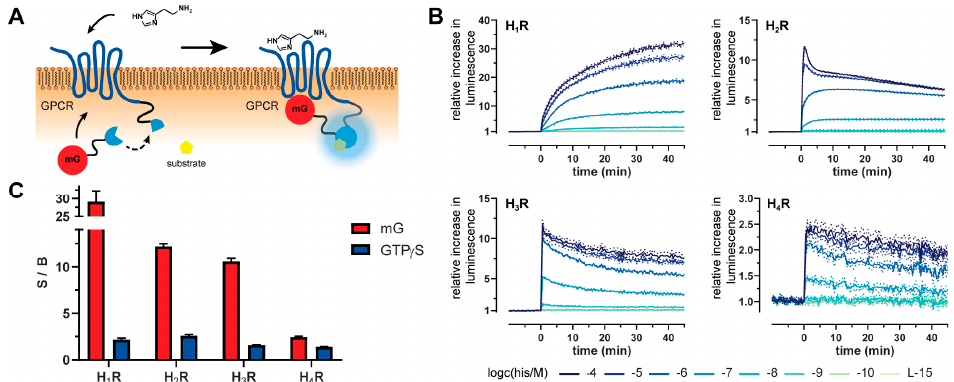
Figure 1. Principle of the mini-G protein recruitment assay and obtained signals at the H 1–4 R. ( A ) Scheme of the mini-G protein recruitment assay. The split-NanoLuc technology was applied to the H 1–4 R (C-terminus) and the mini-G proteins (mG; N-terminus). Upon receptor activation, the mini-G protein is recruited to the GPCR and the split-NanoLuc fragments form a functional enzyme leading to the oxidation of the substrate and thus luminescence signals in an agonist concentration-dependent manner. ( B ) Representative luminescence traces of the mini-G protein recruitment of mGsq to H 1 R, mGs to H 2 R and mGsi to H 3 R and H 4 R. Baseline and inter-well corrected luminescence traces of histamine at various concentrations and the assay medium Leibovitz’s L-15 (L-15) as negative control are plotted. ( C ) Plotted signal-to-background ratios (S / Bs) were calculated from 100% and 0% values of the respective assays, representing top and bottom values of the concentration response curves. For the mini-G recruitment assay (mG), peak or plateau values of the response to 100 µ M histamine (100%) and L-15 (0%) are displayed, whereas for the [ 35 S]GTP γ S binding assay (GTP γ S) responses to 1 mM histamine for H 1,2 R or to 10 µ M histamine for H 3,4 R (100%) and H 2 O (0%) were taken. Presented data are the means ± SEM of at least five independent experiments ( n ≥ 5), each performed in triplicate.